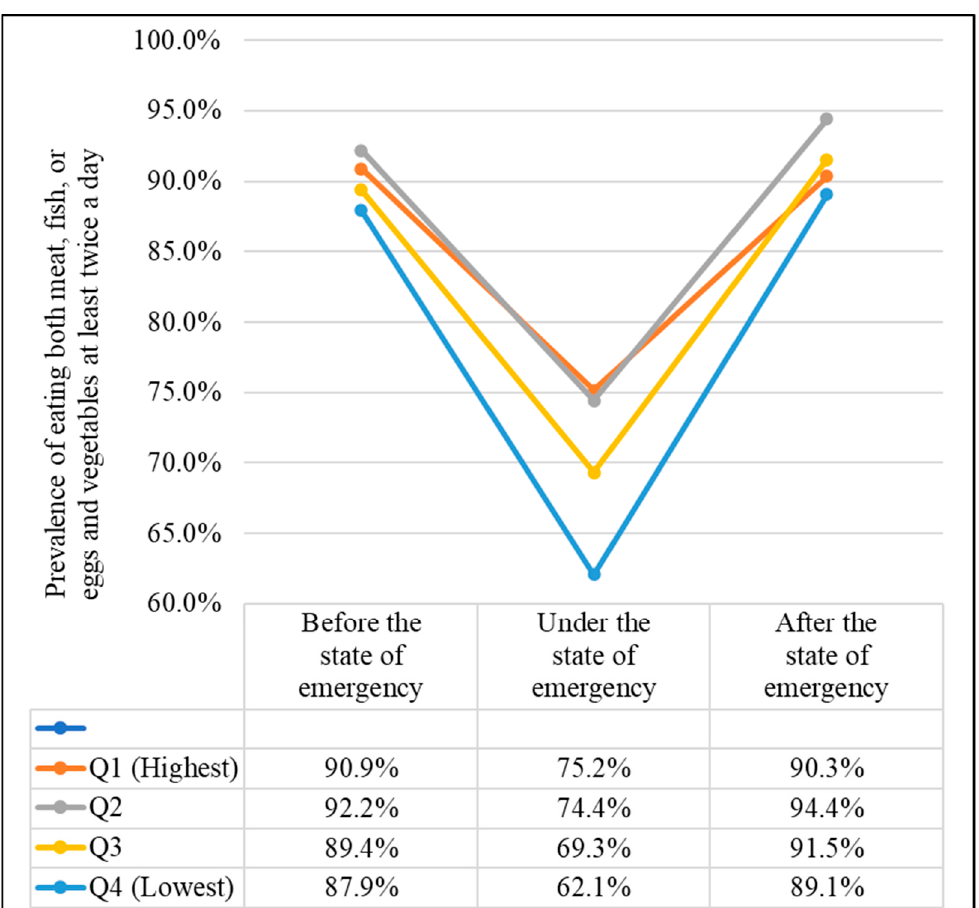
Figure 1. Household income level and prevalence of “well-balanced dietary intake” at least twice a day: 10–14-year-old schoolchildren in Japan before, during, and after COVID-19 state of emergency “Well-balanced dietary intake” was defined as the intake of both meat, fish, or eggs and vegetables.